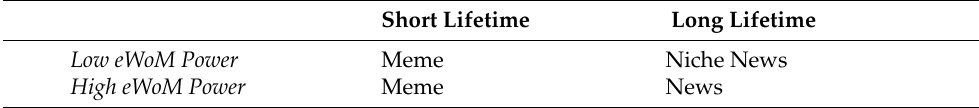
Table 11. Categorization of the posts associated with the lifespan template “Explosive”.